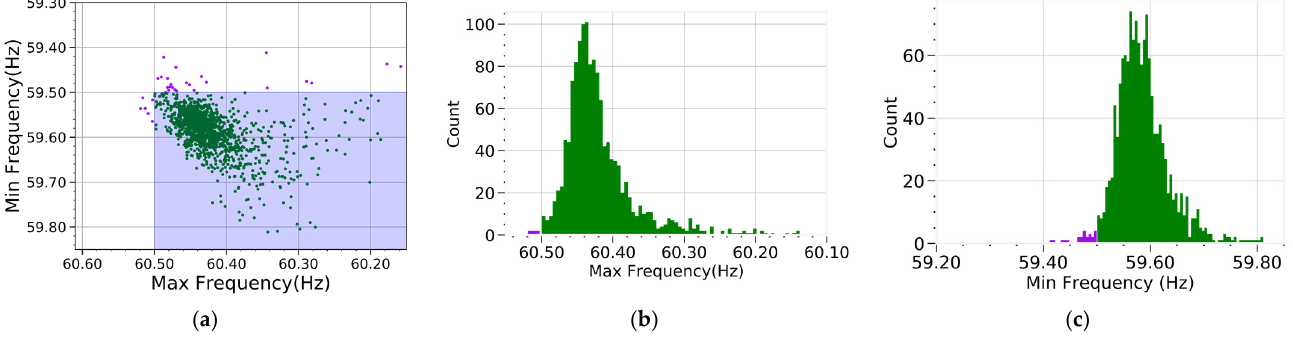
Figure 13. Maximum and minimum frequency and histograms of Island 1 and Island 2: N = 20 (purple: outside secure region, green: inside secure region, shaded area: secure region). ( a ) Max. and Min. frequency; ( b ) Max. frequency histogram in Island 1; ( c ) Min. frequency histogram in Island